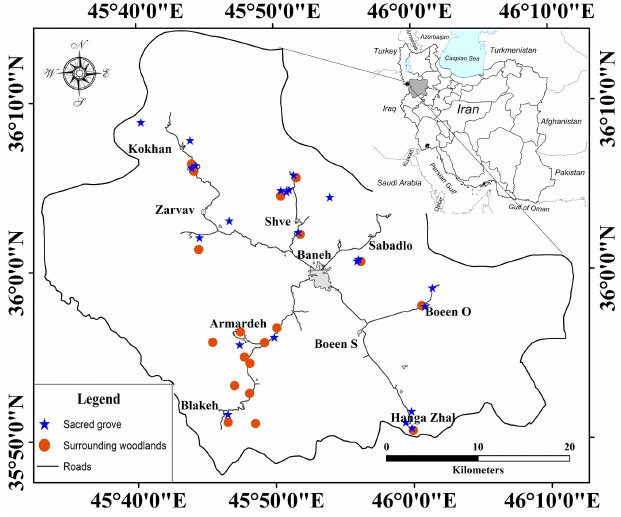
Fig. 1 . Location of selected sacred groves (blue stars) and surrounding woodlands (red circles) in Baneh, northwest